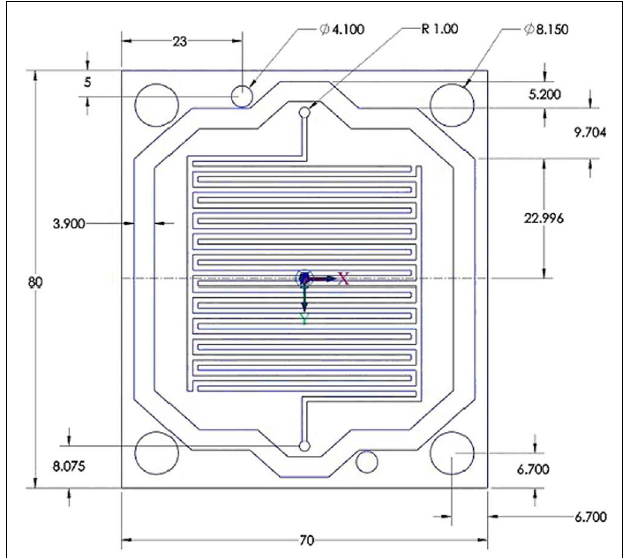
FIGURE 3 | Dimensions of graphite plates with flow channels from the interdigitated flow field design .